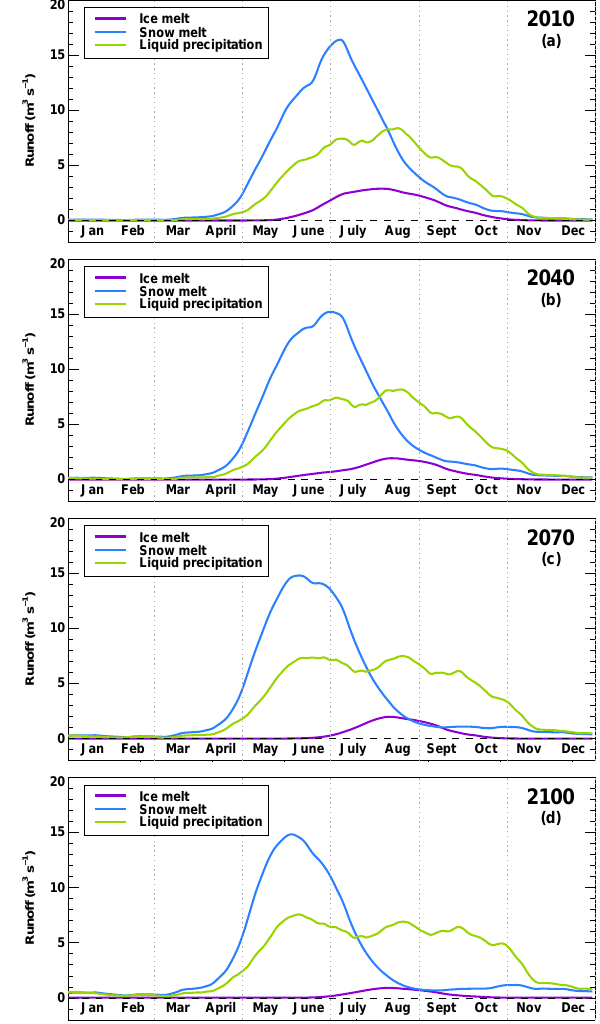
Fig. 9. Evolution of the three components of the water input to the runoff routing model for the years 2010 (a) , 2040 (b) , 2070 (c) , and 2100 (d) . The values are averaged over ±